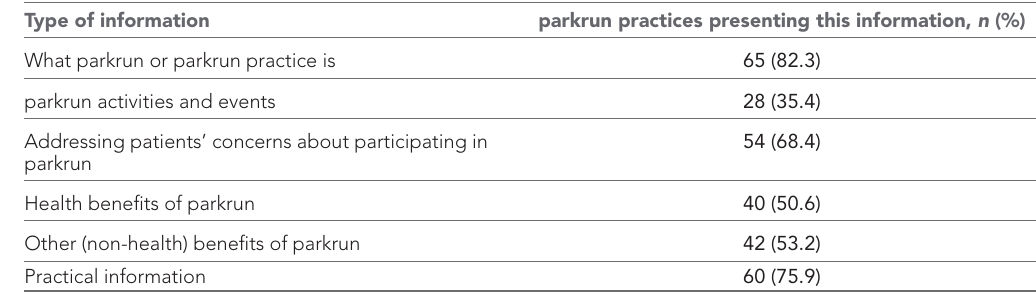
Table 3 Presentation of types of information ( N =